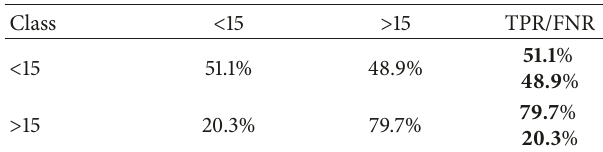
Table 1: Binary classification with class separation at 15 𝜇 g/m 3 . Table 2: Confusion matrix of binary classification for Cotocollao using a BT. Rows represent the true class and columns represent the predicted class.